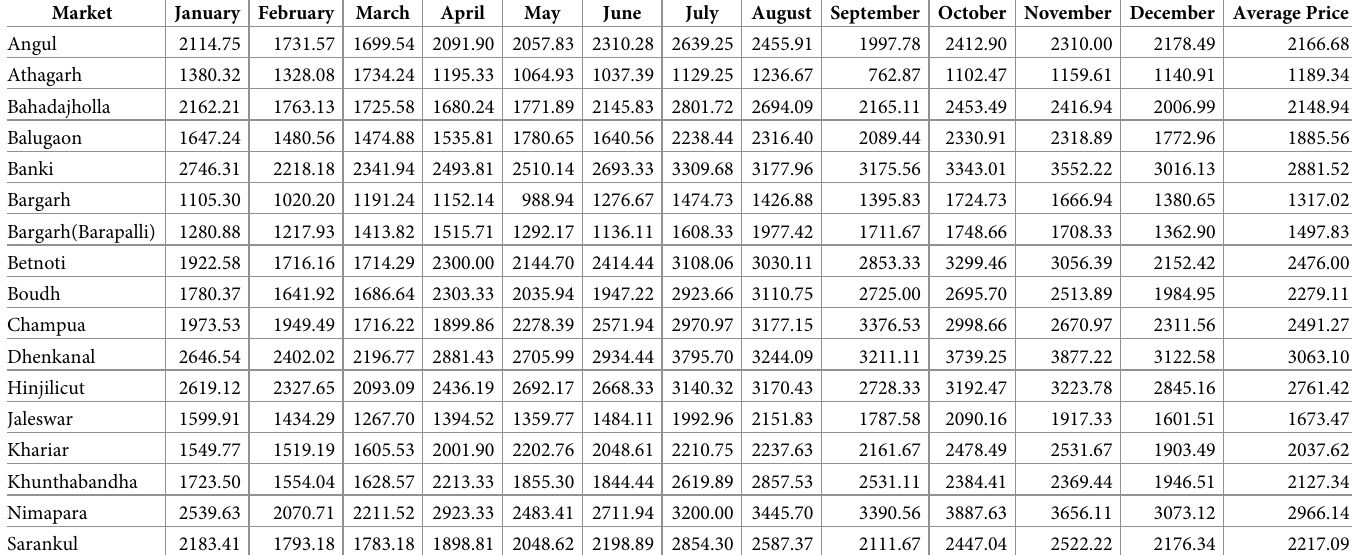
Table 3. Average monthly price of brinjal in important markets in